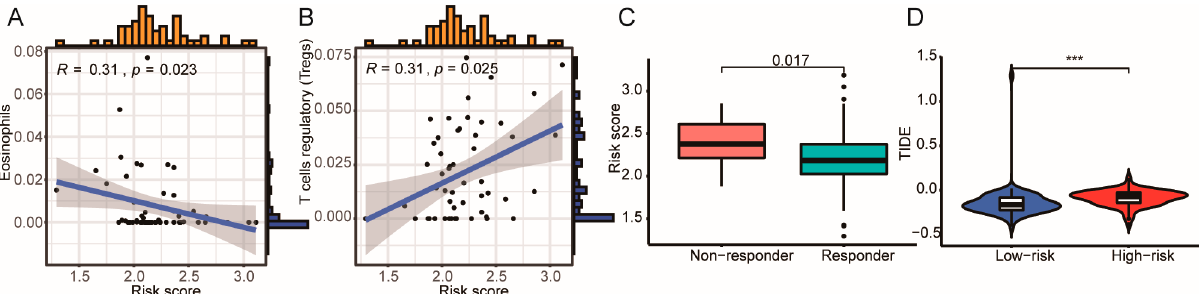
Figure 8. The prognostic value of ICD prognostic signature model and immunotherapy sensitivity. Correlation between ICD prognostic risk score with the content of eosinophils ( A ) and T Cells regulators ( B ). ( C ) Risk scores for the response to ICB immunotherapy in different patients. ( D ) Immunotherapy escape in different patients of ICD prognostic risk scores. (*** p < 0.001 vs. indicated group).